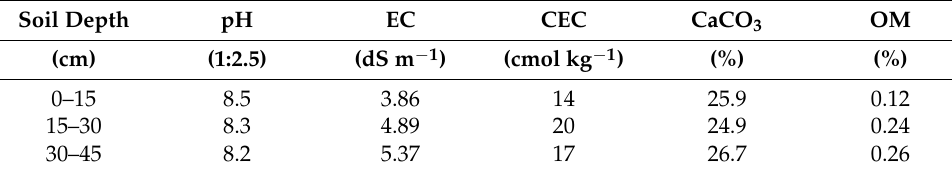
Table 2. Chemical properties of soil at the experimental site.